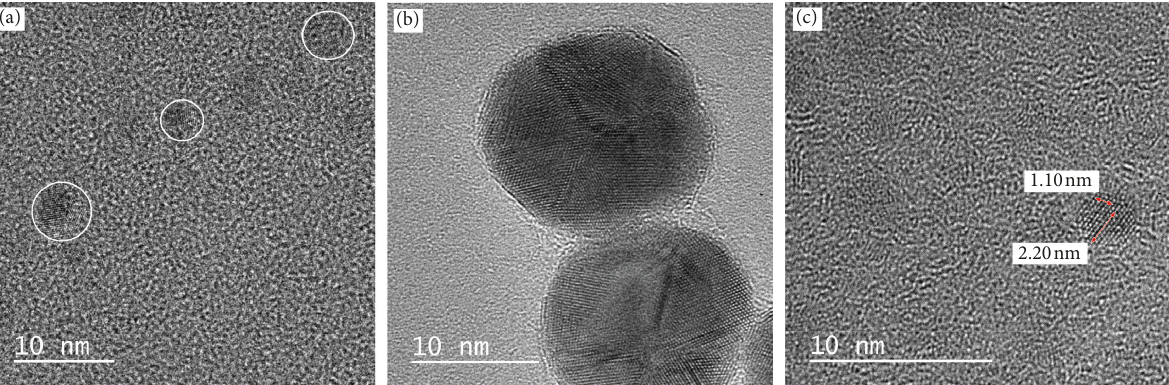
Figure 14: HR-TEM images recorded for the MnTTPCl/n-Au hybrid treated with β -carotene (a), the n-Au treated with β -carotene (b), and MnTTPCl treated with β -carotene (c).